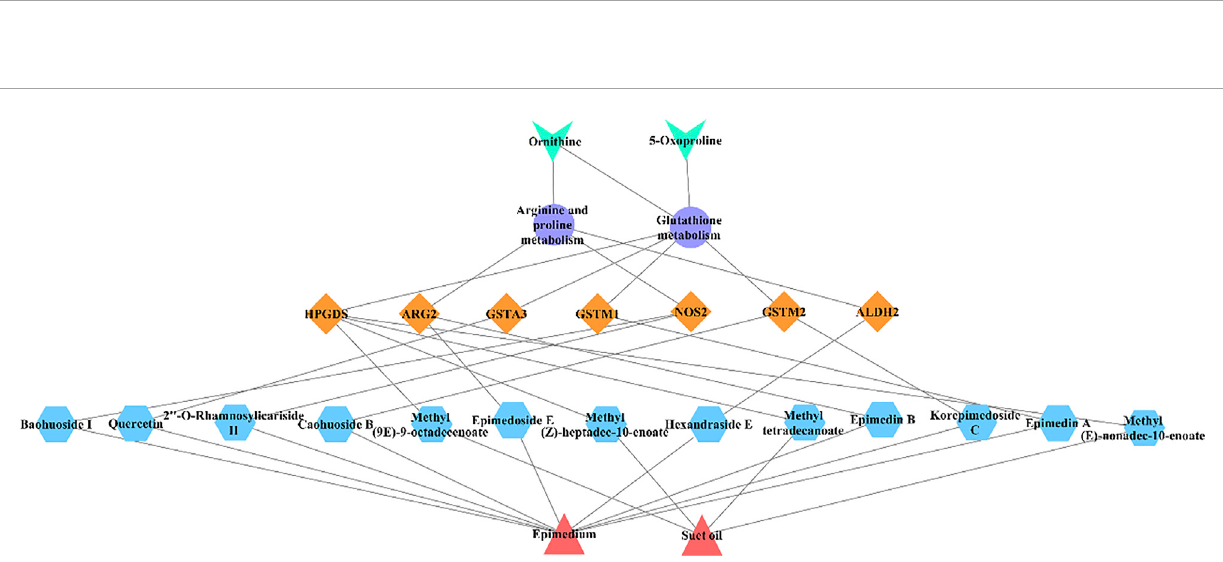
FIGURE 12 Theoverallinteractivenetwork diagrampinktrianglesindicate drugs, bluehexagons indicate activecompounds,yellowdiamondsindicate target genes, purple ellipses indicate pathways, green “ V ” indicates biomarks.